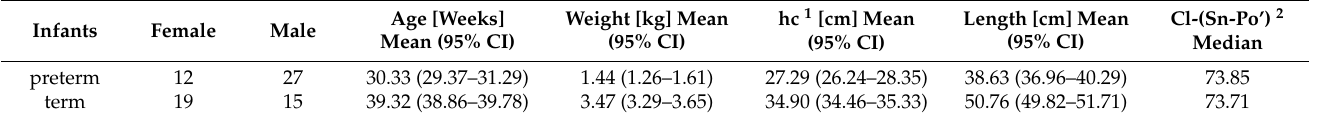
Table 1. Baseline characteristics of preterm and term infants on the first day of examination. Mean and 95% confidence intervals of gestational age, weight, head circumference (hc), and body length at birth. Median of the profile angle between Camper’s line (Cl) and a line between the landmarks Subnasale (Sn) and Pogonion molle (Po’). Except for the profile angle (Cl-(Sn-Po’)), all values are significant differently ( p < 0.000) between both